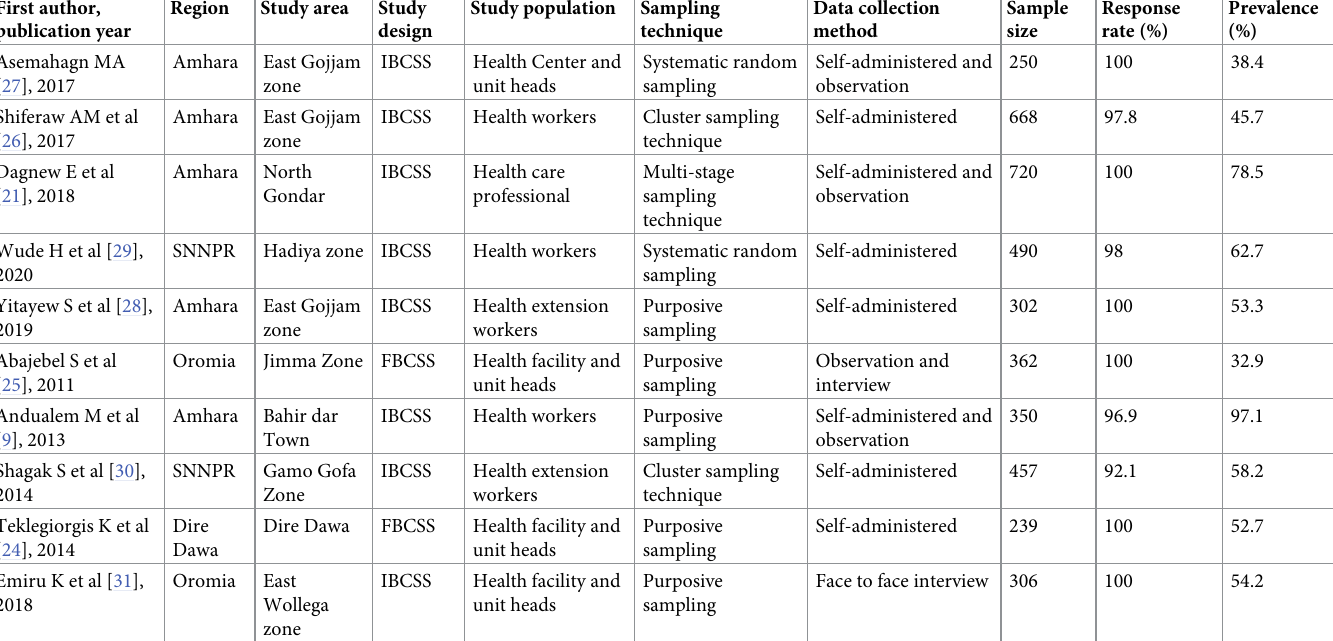
Table 1. Descriptive summary of primary studies included in the meta-analysis of utilization of routine health information and associated factors among health workers in Ethiopia, 2020.